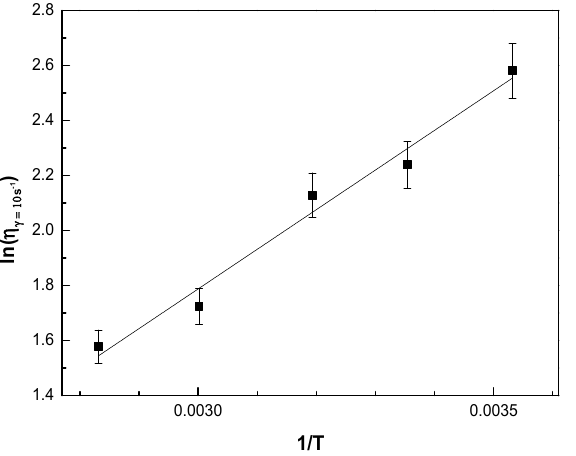
Figure 2. Viscosity at 10 s − 1 (as function of the temperature of hydrocolloids from Pereskia bleo leaves.